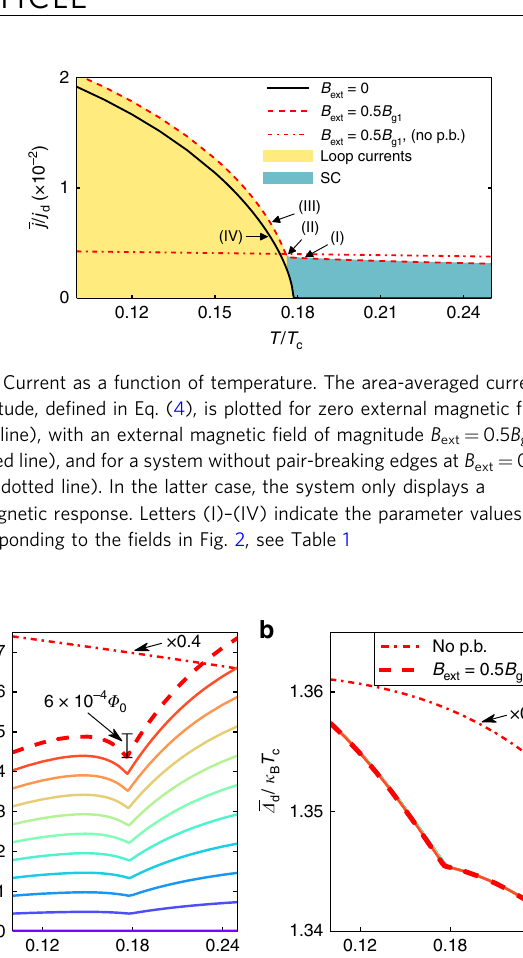
both as functions of temperature for different values of B ext . The fi gures also show results for a d -wave grain without pair-breaking edges at B ext = 0.5 B g1 (dash-dotted line). For better visibility, the latter results have been scaled by a factor 0.4 and 0.9 in (a) and (b), respectively. Two different trends are distinguishable in the observables for T < T * and T > T * , separated by a “ kink ” . The induced magnetic fl ux through the grain area decreases as T decreases down to T * due to the increasing paramagnetic response that competes with the diamagnetic one. At T * , the inhomogeneous edge state appear and starts competing with the paramagnetic response. Thus, the total magnetic fl ux increases again. At the same time, the order parameter is partially healed.